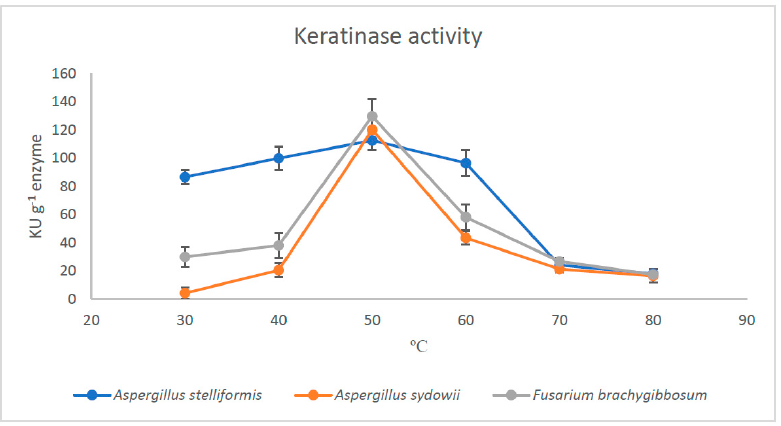
Figure 4. Effect of pH on the activity of fungal keratinases produced by A. stelliformis, A. sydowii, and F. brachygibbosum .